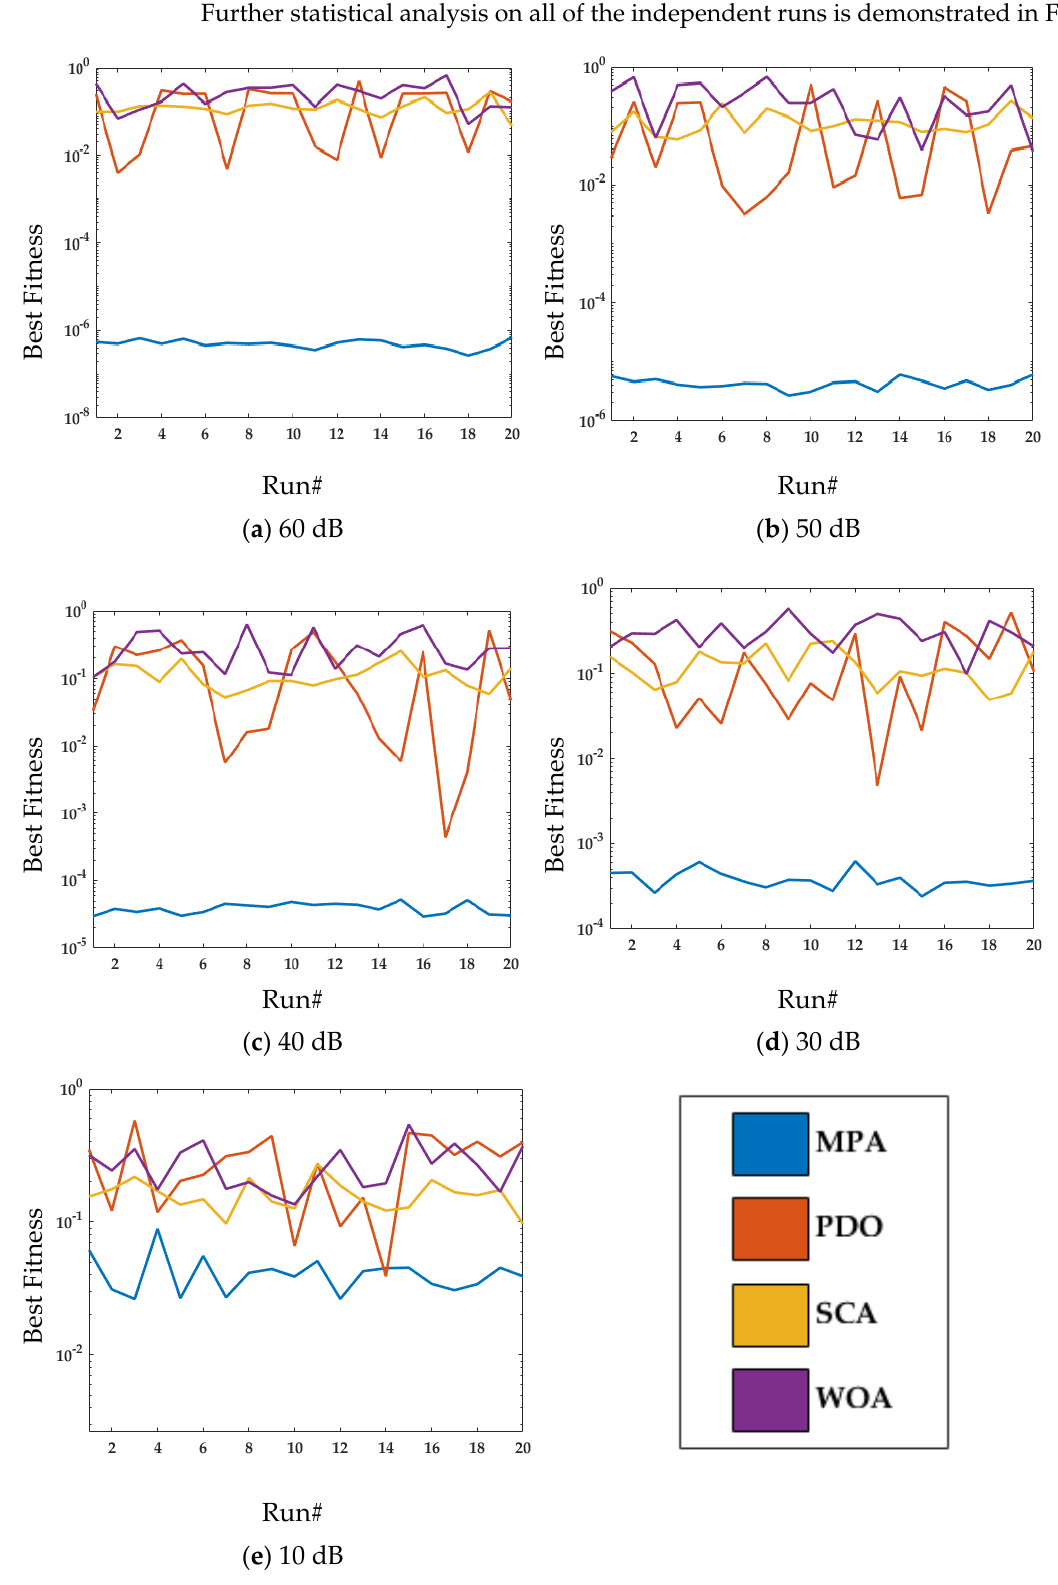
Figure 7. Statistical comparison of MPA with PDO, SCA, and WOA at Np = 100 and T = 1000 for case study 1.